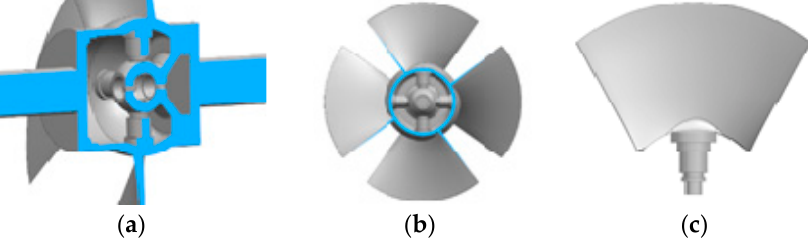
Figure 5. Structure diagram of the impeller, ( a ) side view of middle section, ( b ) axial direction view of middle section, and ( c ) structural model of the blade.